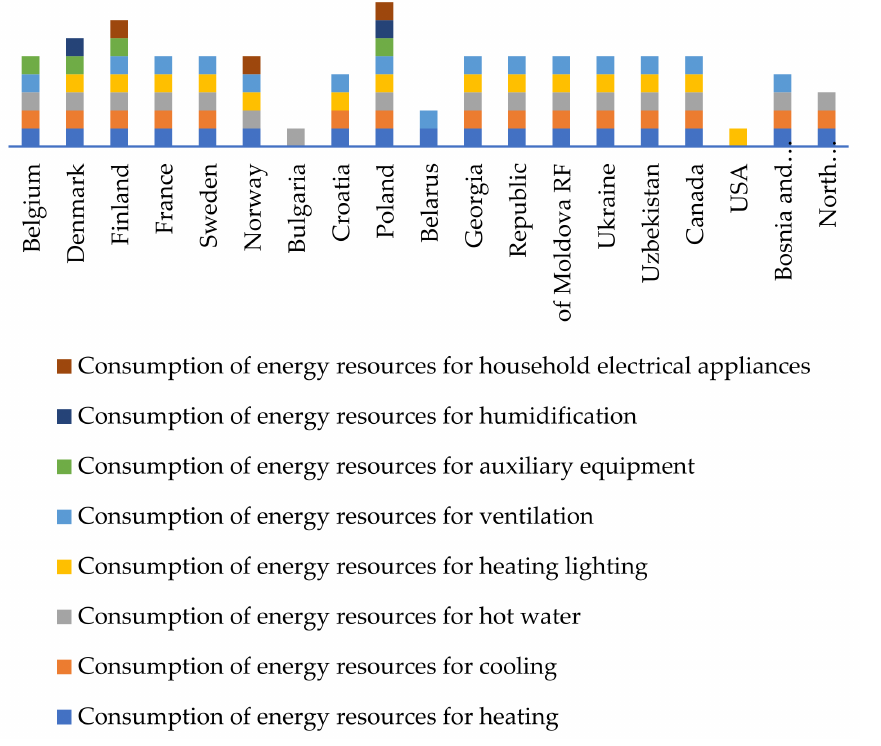
Figure 1. Accounting for the consumption of energy resources in terms of energy efficiency of buildings (built by the authors based on the “Comparative review of existing technologies to improve the energy efficiency of buildings in the UNECE region in 2019” [35]).